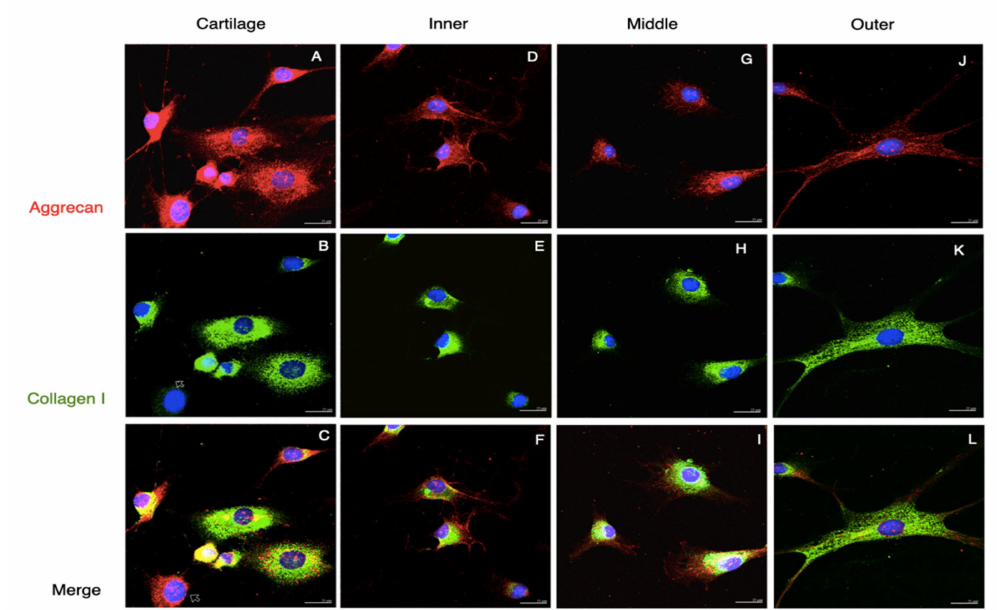
Figure 6. Collagen I and aggrecan staining of passage 2 cultured cells. Immunofluorescence demon- strated the Agg and Col I staining of passage 2 cultured cells from the cartilage and meniscus. Agg staining displayed punctuate patterns scattered in the cells (arrow in ( A , C , D , F , G , I , J , L )), whereas Col I staining was mostly found around the nuclei (arrowheads in ( B , E , H )). Some cells from the cartilage were absent of Col I staining (hollow arrows in ( B )). And cells from outer meniscus clearly presented Col I staining ( K , L ). Scale bars: 25 µ m.